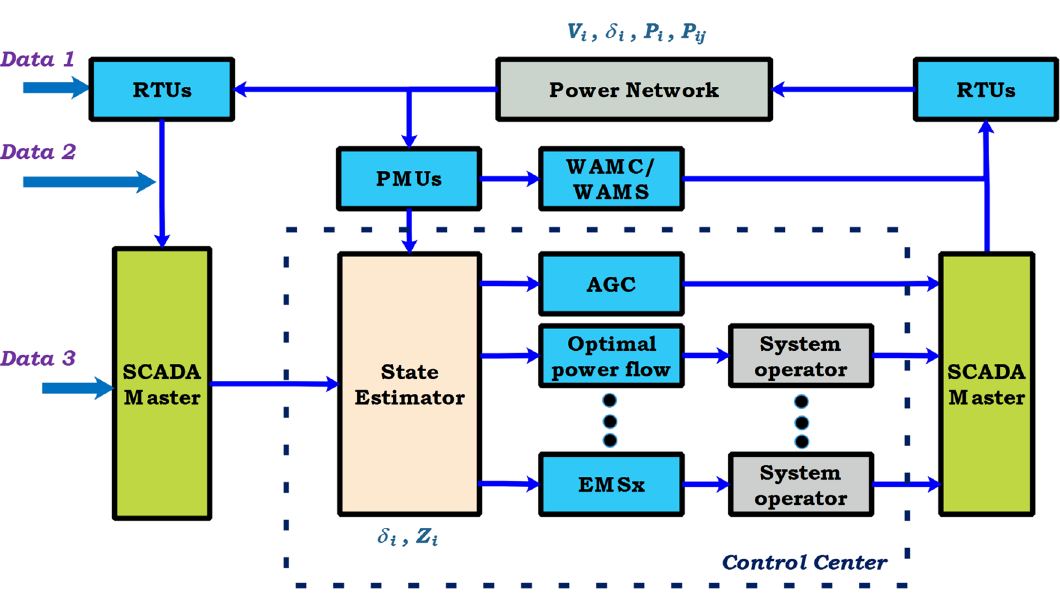
Figure 10. Data injection attack on power grid—a schematic